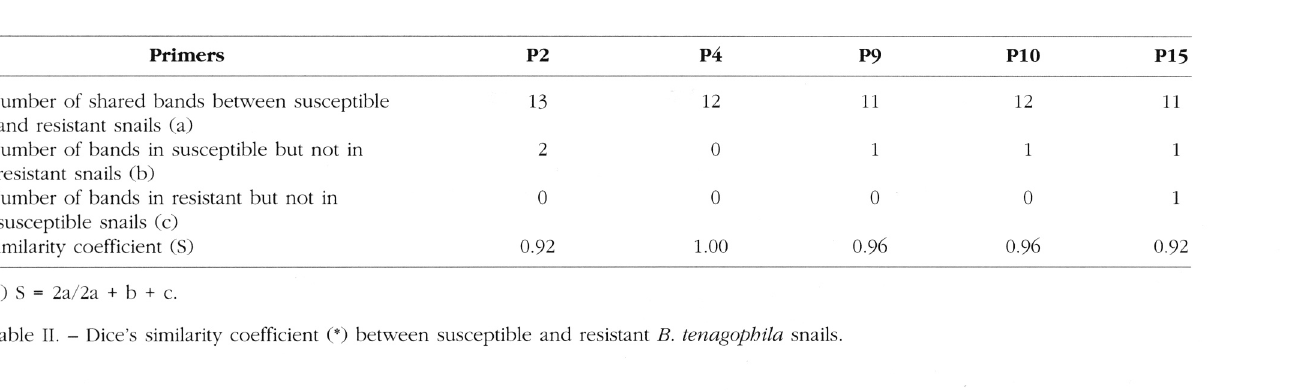
Table II. - Dice’s similarity coefficient (*) between susceptible and resistant B. tenagophila snails.